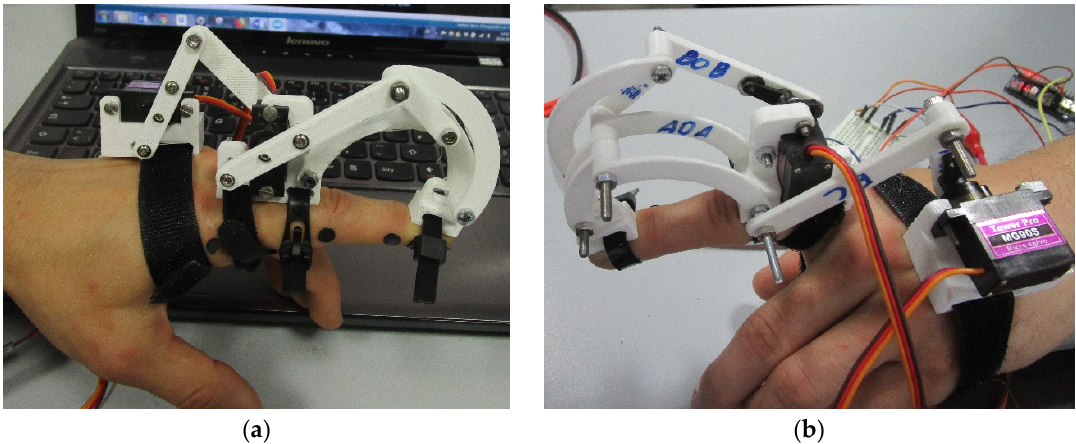
Figure 18. The built prototype of the finger exoskeleton, front view ( a ), back view ( b ).